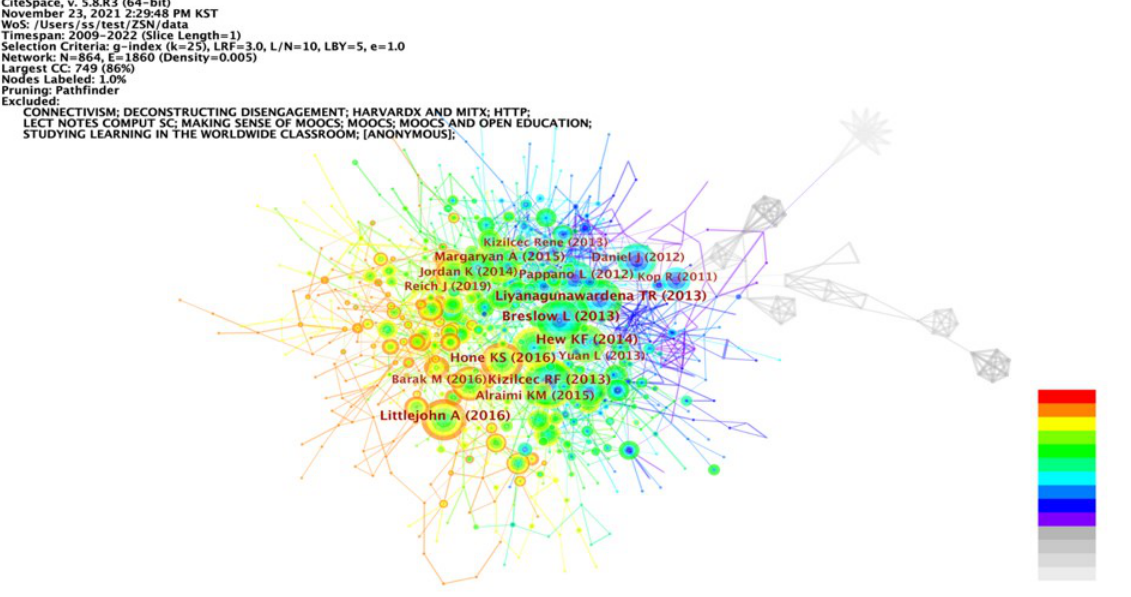
Figure 1 Network of Top 10 Co-Citation References (2009 –